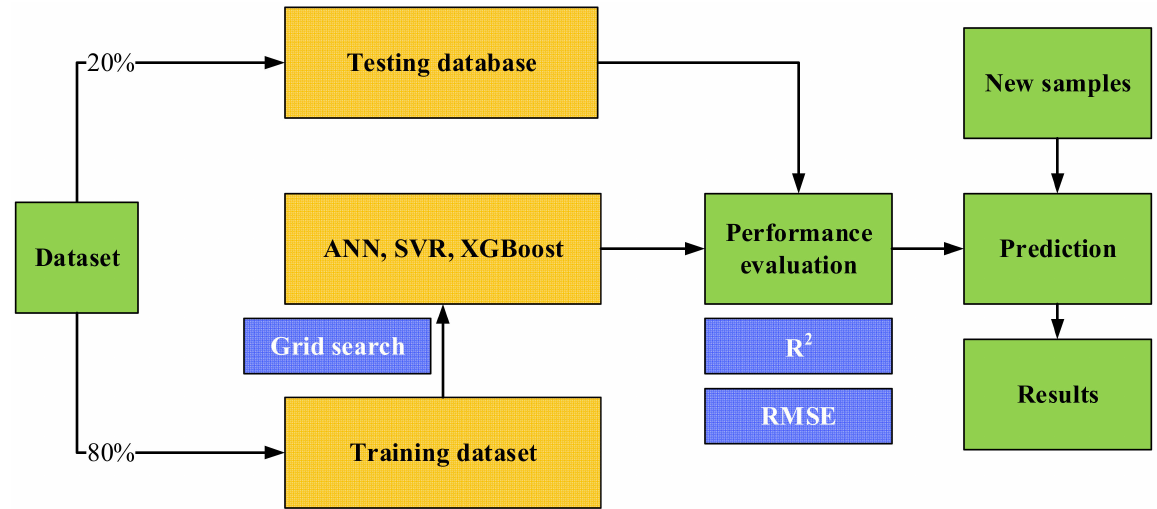
Figure 4. Flowchart of developing the ML